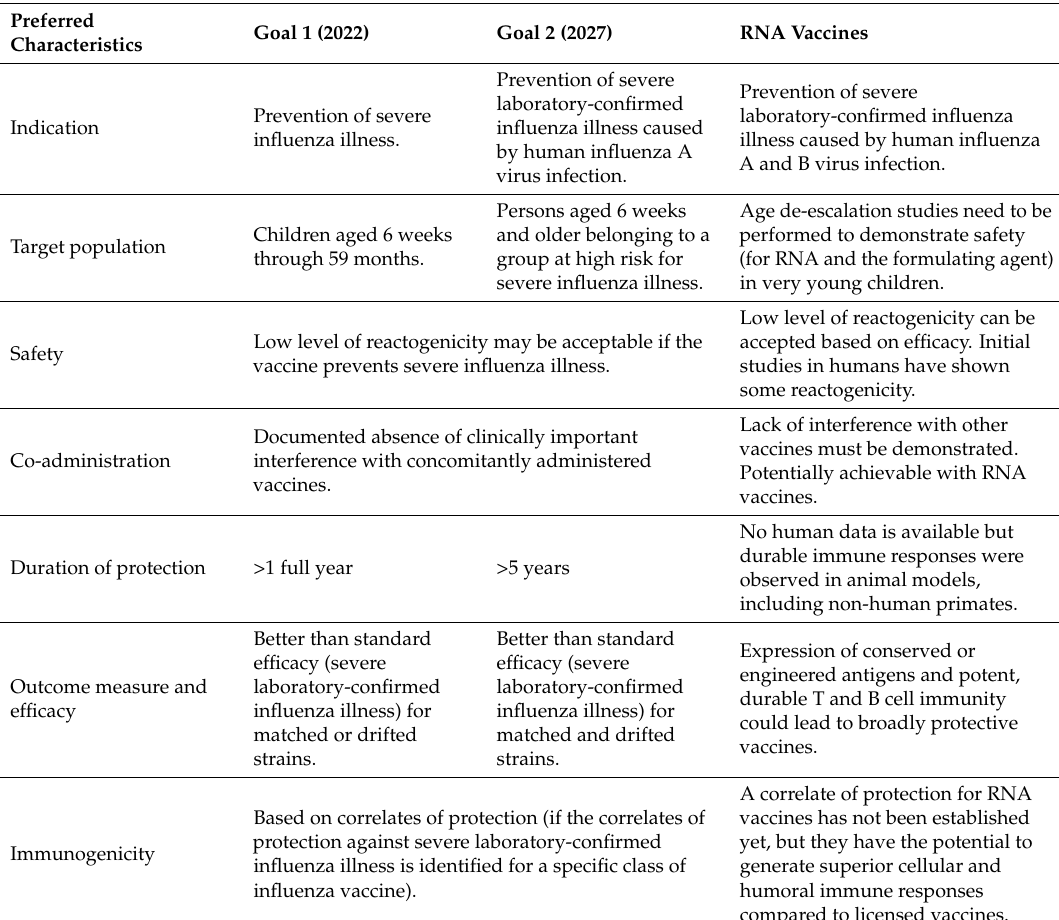
Table 5. Summary of the WHO PPC document on next-generation influenza vaccines and relevant considerations for RNA